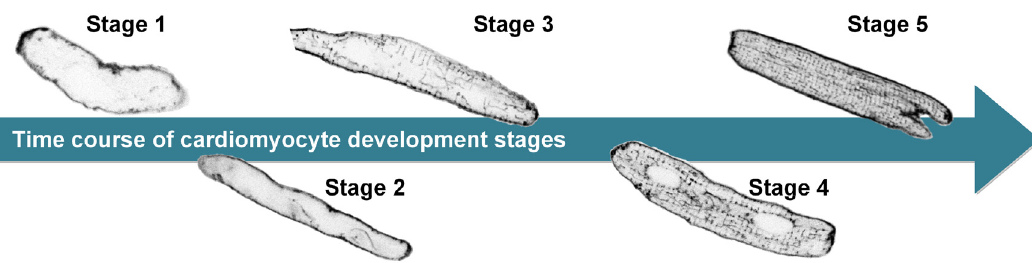
Fig 1. Development stages of cardiomyocytes. The images of cardiomyocytes are ordered from left to right according to their developmental stages, from the least to the most developed (stage 1 to stage 5).